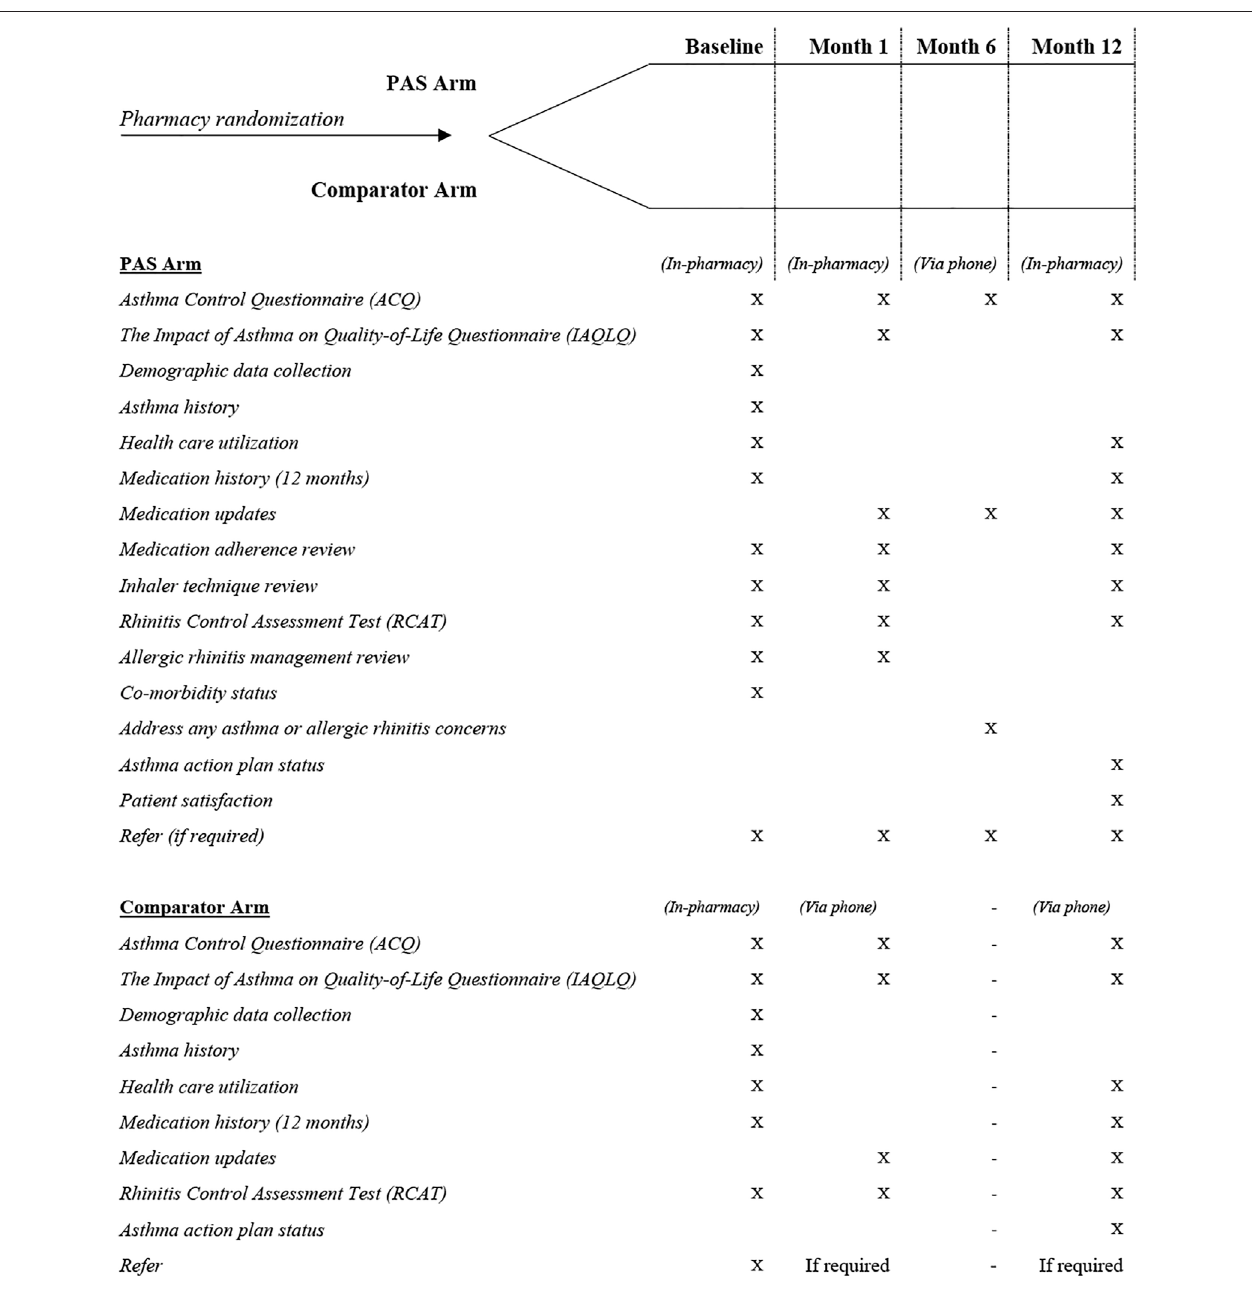
FIGURE 1 | PAS and Comparator arm patient